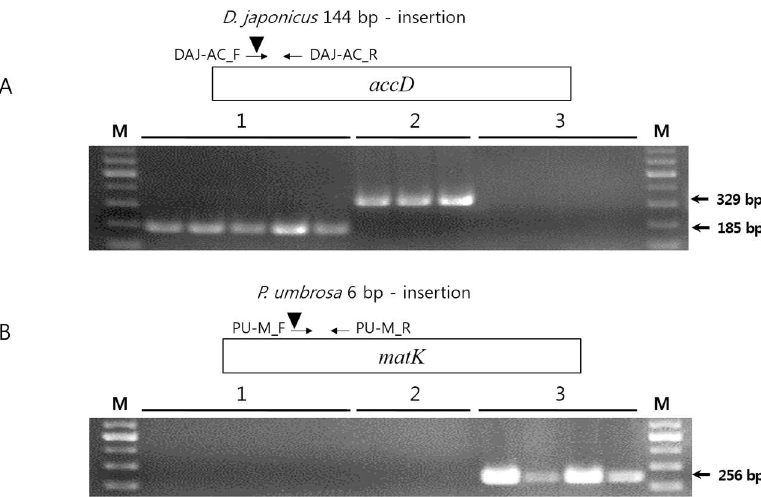
Figure 6. The gel images of CP DNA of D. asper , D. japonicus , and P. umbrosa amplified using sequence characterised amplified region (SCAR) markers. Twelve individual plants were used in this study using ( A ) DAJ-AC and ( B ) PU-M primers. Details of the germplasm are provided in Supplementary Table S10. ( 1 ) D. asper , ( 2 ) D. japonicus , ( 3 ) P. umbrosa .